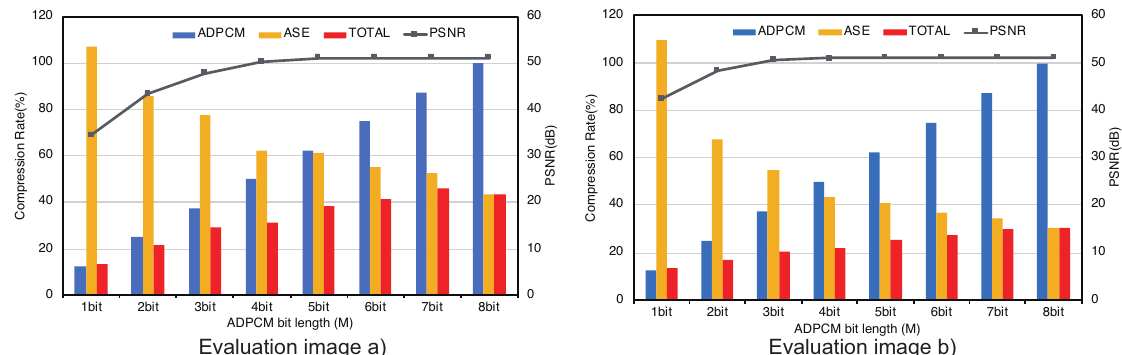
Figure 6. PSNRs and compression ratios regarding ADPCM-VBL and ASE coding. The graph in the left and the one in the right show the results regarding the evaluation image a) and b) shown in Figure 5, respectively.